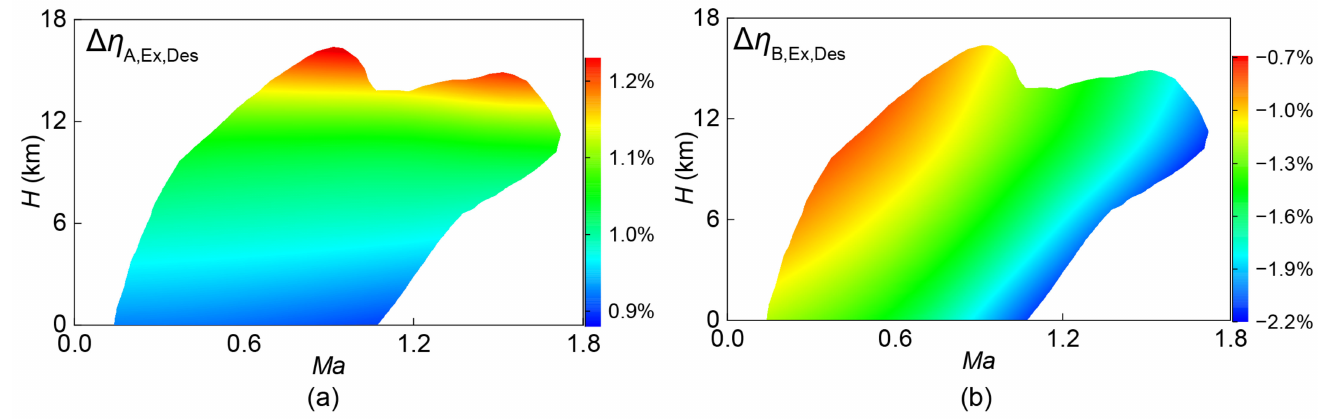
Figure 15. Variations of exergy destruction rate in the full flight envelope. ( a ) The ratio of η A,Ex,Des in schemes A and F-119; ( b ) The ratio of η B,Ex,Des in schemes B and F-119.